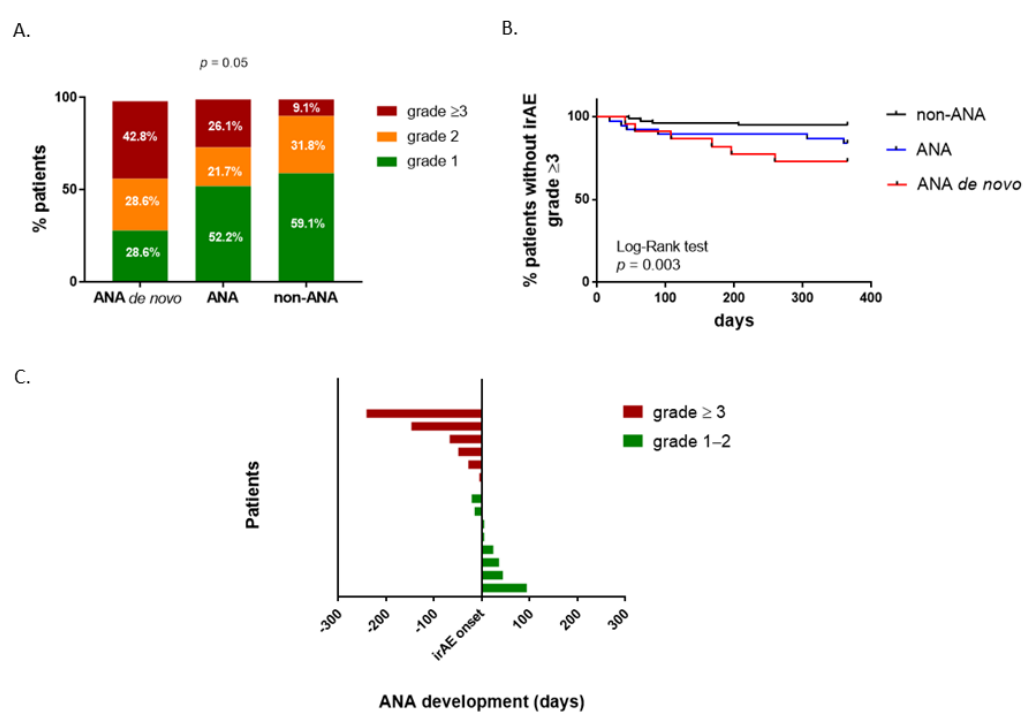
Figure 3. Comparison of irAE onset and severity between groups. ( A ) Association of severity of irAEs and ANA development. ( B ) Staircase graphs show the percentage of patients without grade ≥ 3 irAE over time in patients grouped according to ANA presence during ICI treatment. ( C ) Relationship between the moment of appearance of new ANAs during ICB treatment and the moment of irAE onset. Each bar represents one patient. Log-rang Mantel–Cox test was used for analysis of patient groups during the 365 days of follow-up.